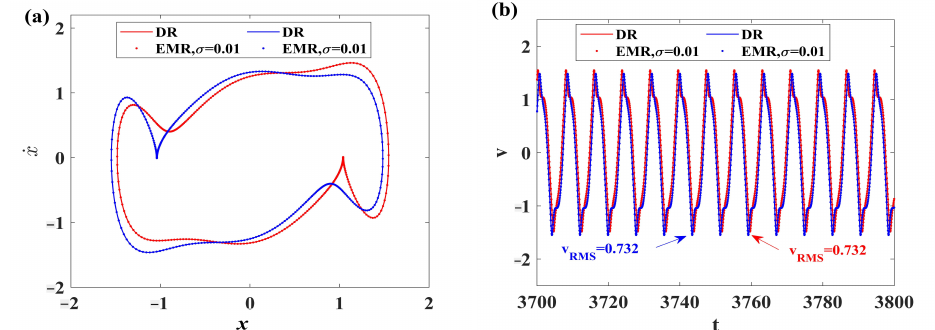
Figure 5. DR and EMR ( σ = 0.01) for ζ =1.5. ( a ) Phase portraits; ( b ) Time history of the output voltage. The blue dots and red dots are obtained under the initial conditions (IC-1) and (IC-2), respectively.